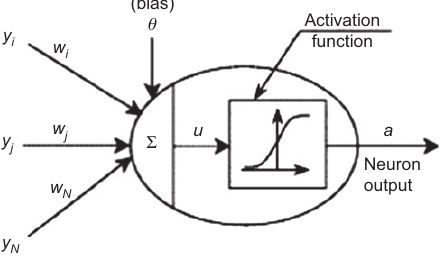
Figure 4 McCullogh and Pitts neuron model [22]